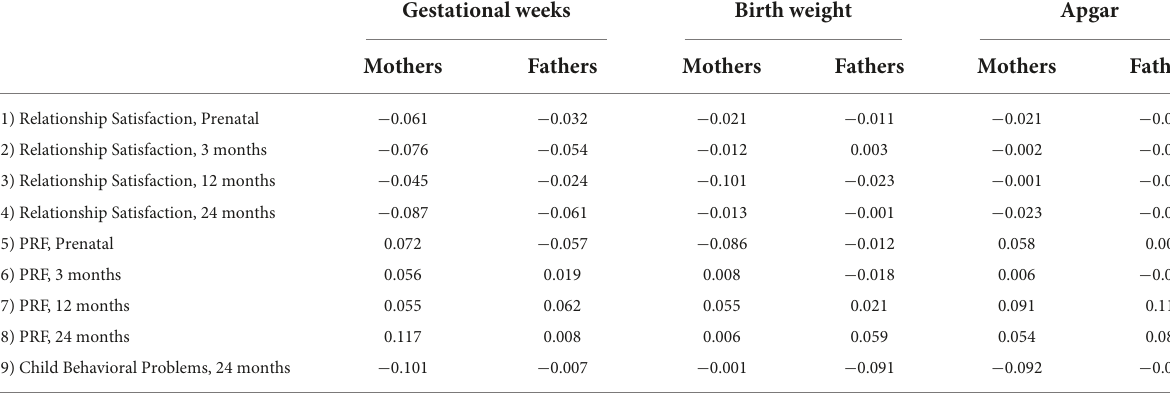
TABLE 4 Correlations between the child characteristics and the study variables for mothers and fathers.